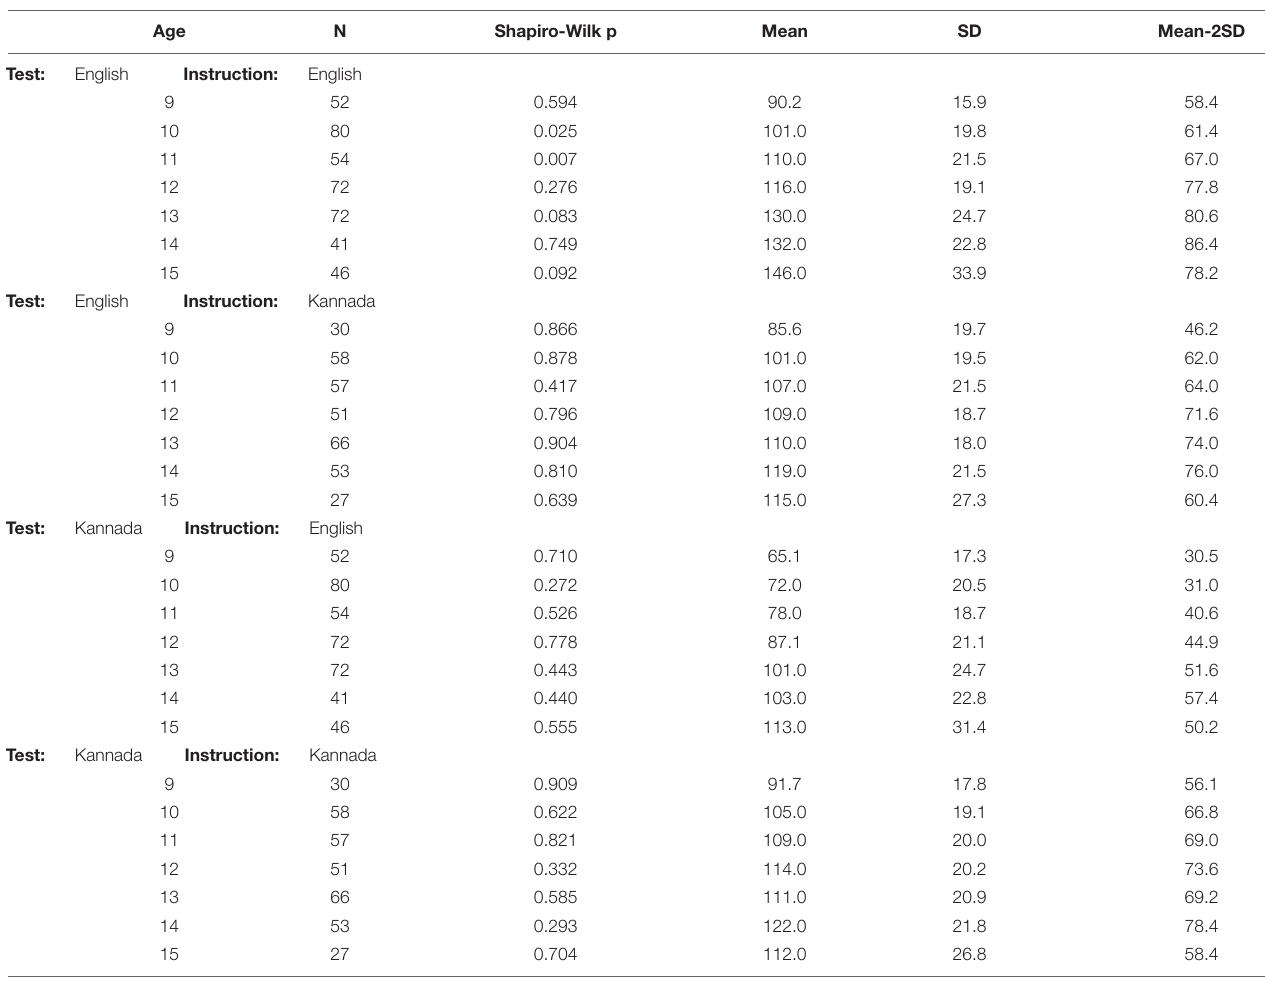
TABLE 2 | Reading rate summary statistics, by test, medium of instruction, and age.